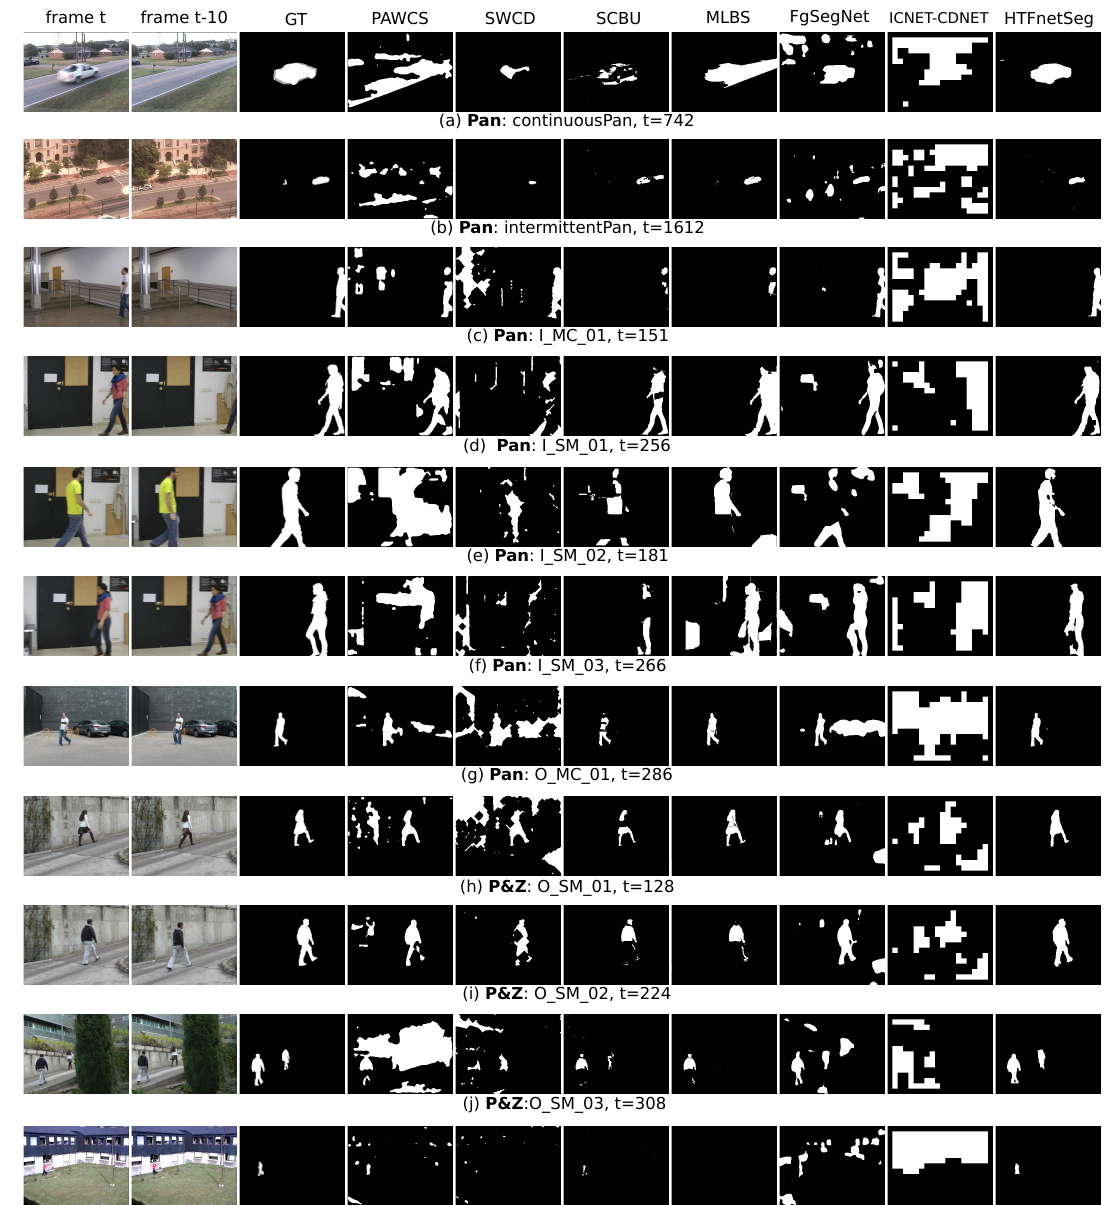
Figure 5. Qualitative results comparison on the seven algorithms. The first column is the current frame F ( t ) and the second column is one of the reference frames F ( t − 10 )